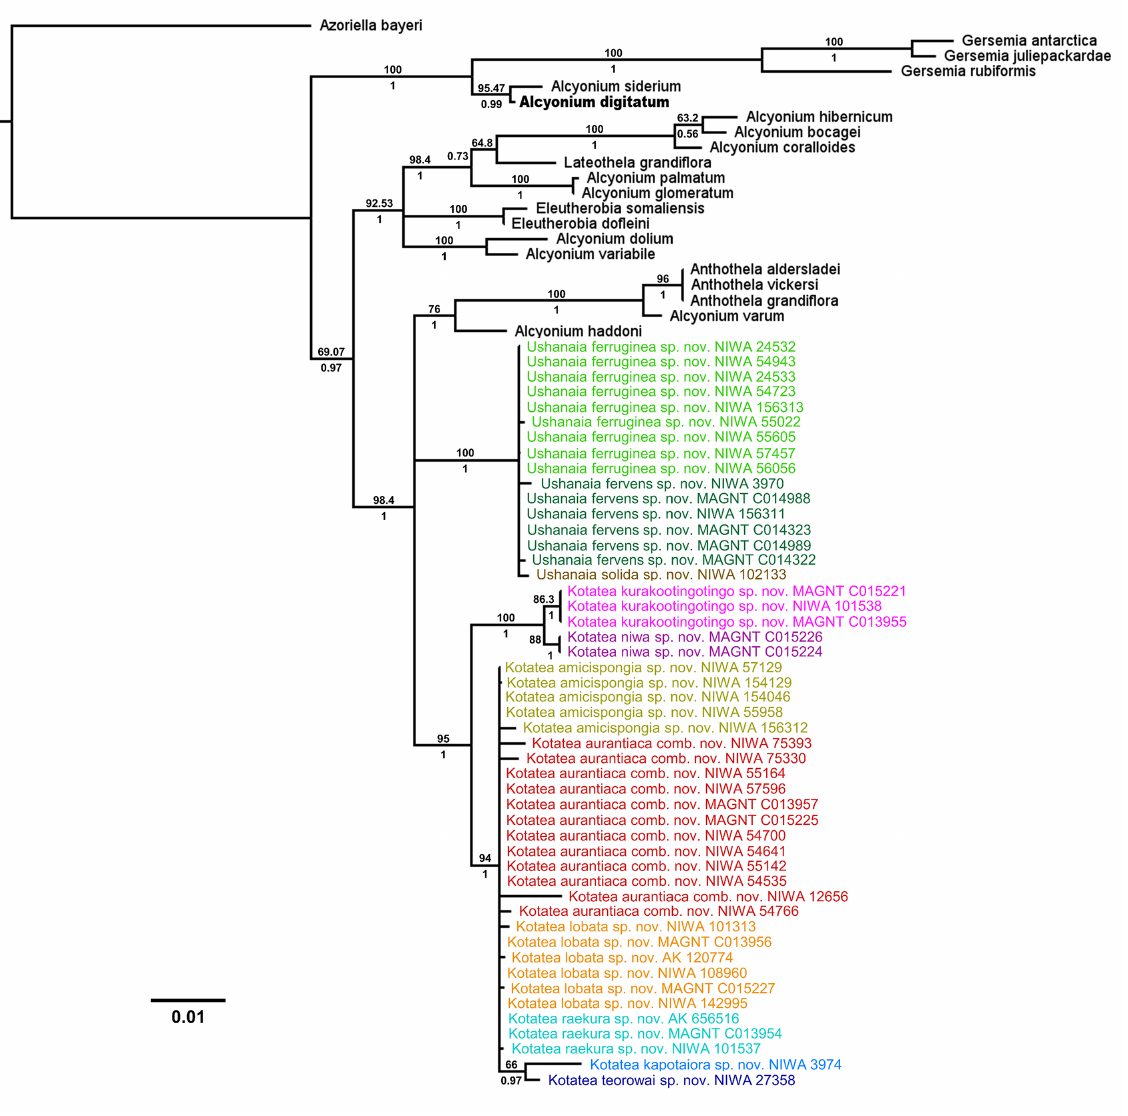
Fig. 37. Maximum likelihood phylogeny (identical in topology to Bayesian inference phylogeny) of Kotatea gen. nov., Ushanaia gen. nov., and associated taxa based on combined, partitioned analysis of mtMutS and 28S . New species are identified by individual colours. The type species for Alcyonium Linnaeus, 1758 – A. digitatum Linnaeus, 1758 – appears in bold. ML bootstrap support values are given above each branch and BI posterior probabilities